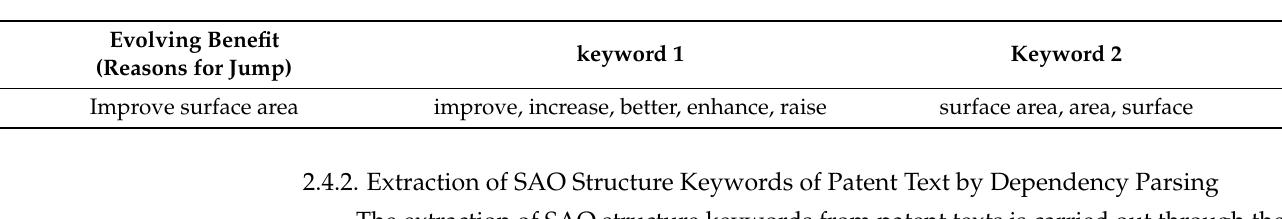
Table 3. Example of synonym expansion for evolutionary benefits